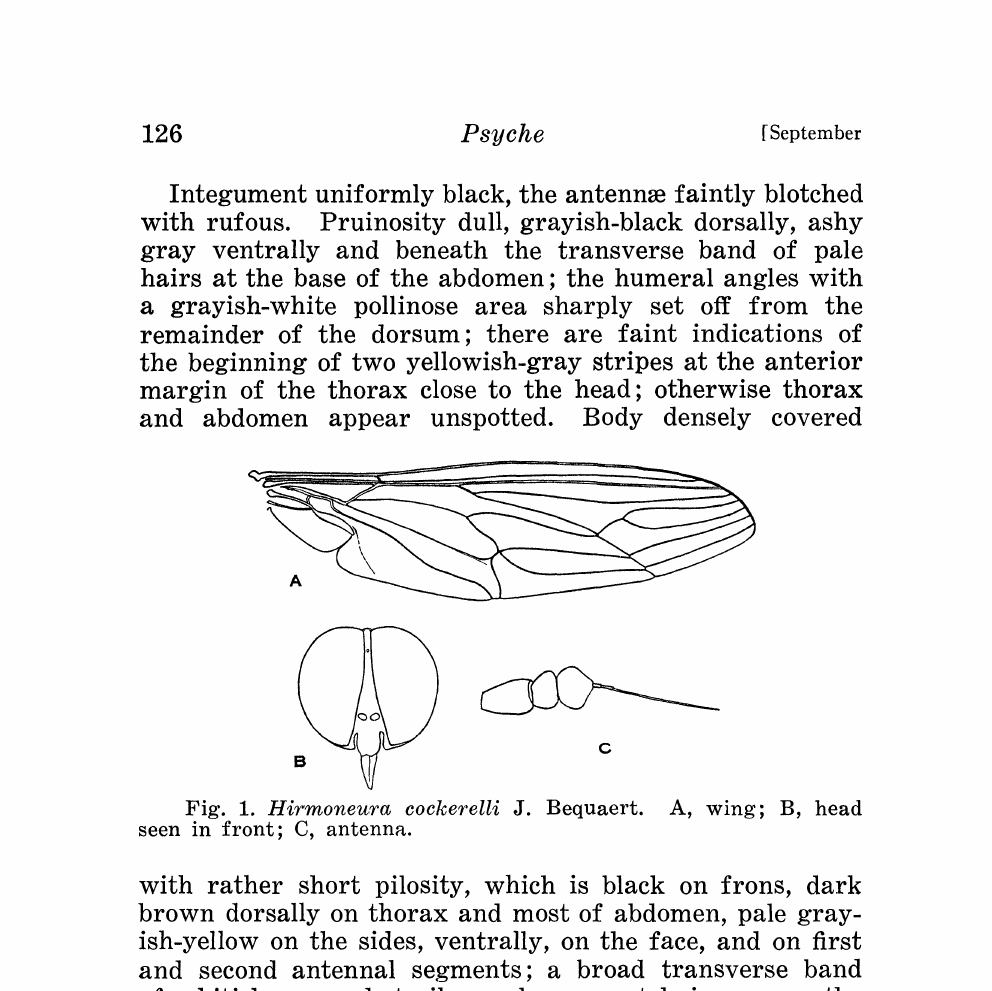
Fig. 1. Hirmoneura cockerelli J. Bequaert. A, wing; B, head seen in front; C,